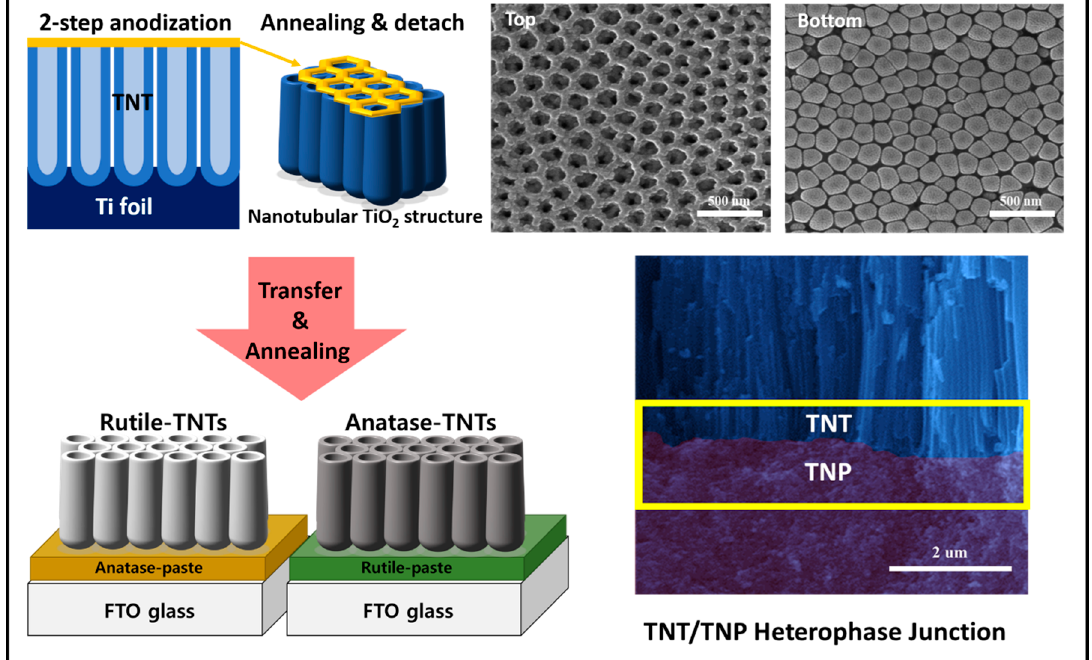
Figure 1. Schematic illustration of fabrication process for the hierarchical TiO 2 heterophase junction.